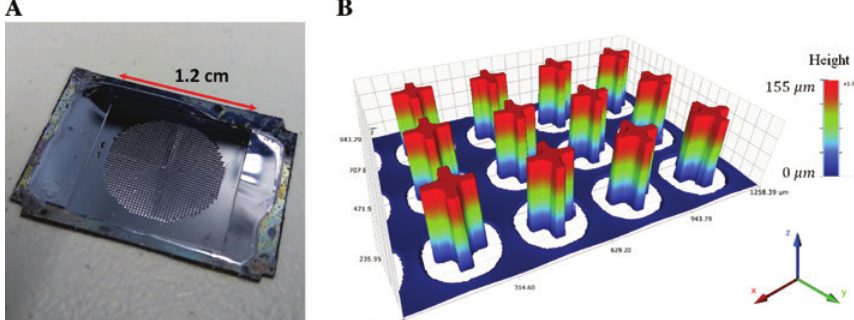
Figure 5: THz vortex generator and the height profile of the cross resonators measured using optical profiler. (A) Photo of the fabricated metadevice for vortex beam generation. (B) Depth profile measured using an optical profilometer (Bruker).